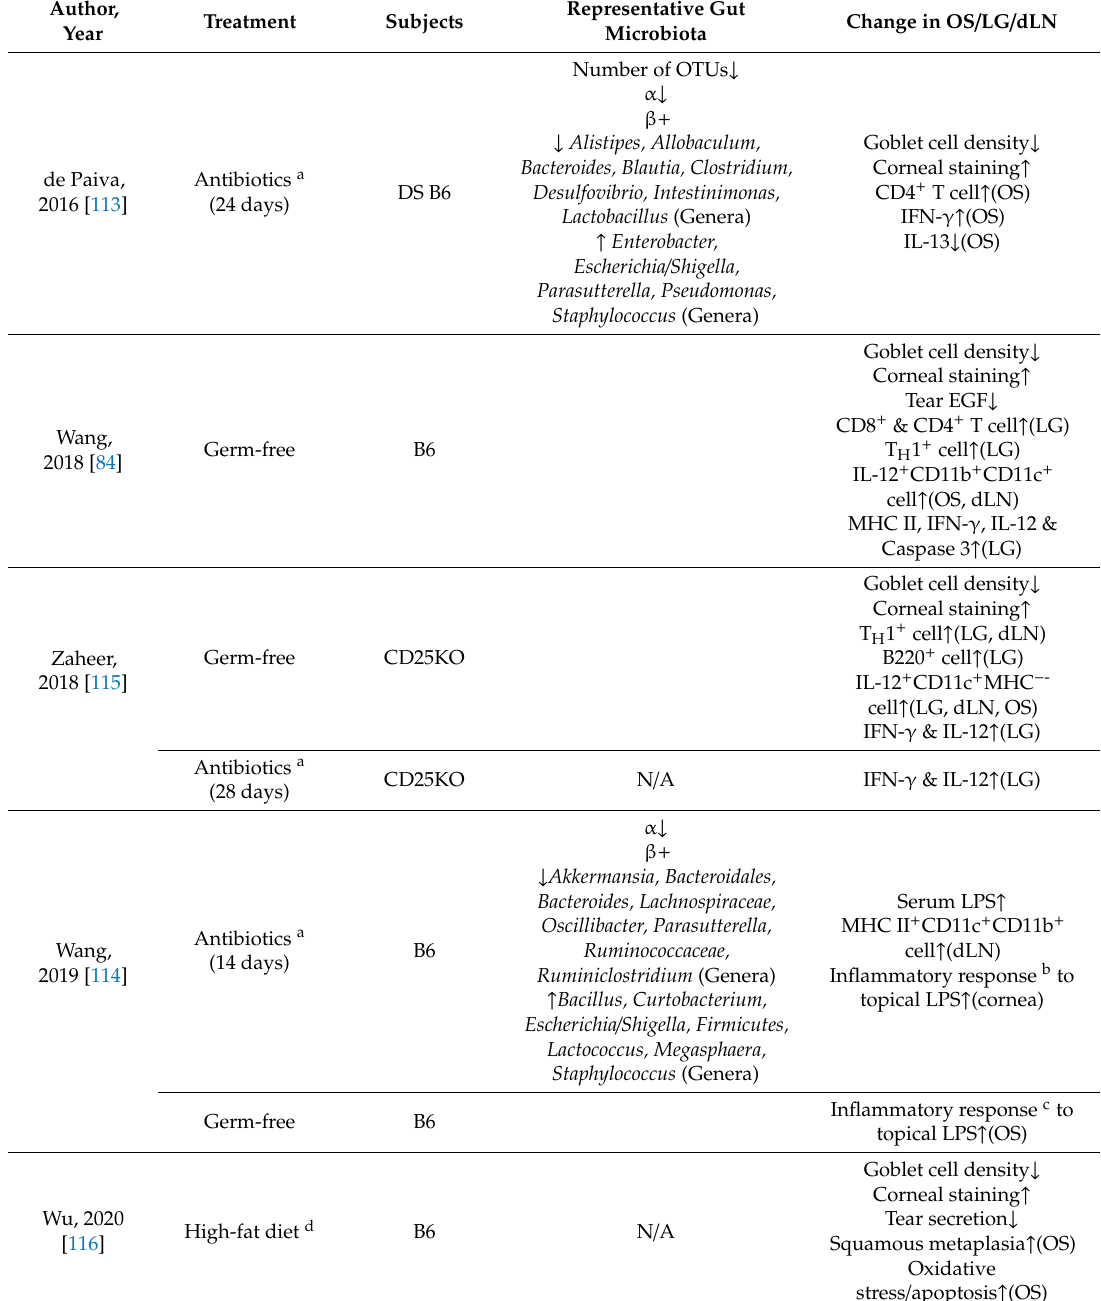
Table 4. Dry eye rodent models related with gut